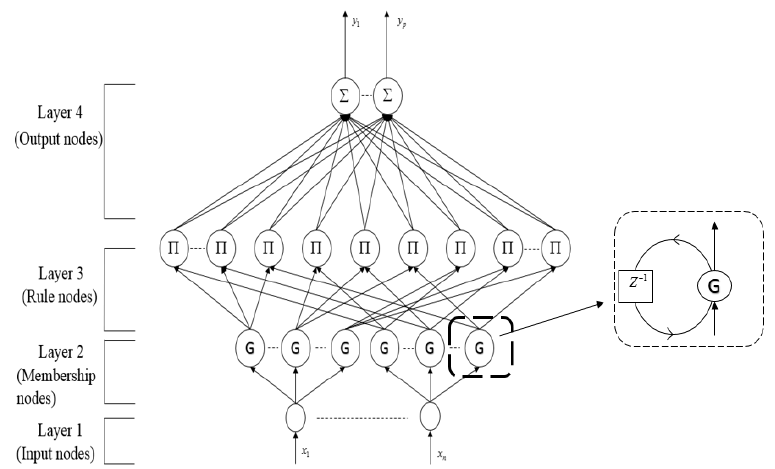
Figure 3. The configuration of the proposed recurrent fuzzy neural network (RFNN) [21].